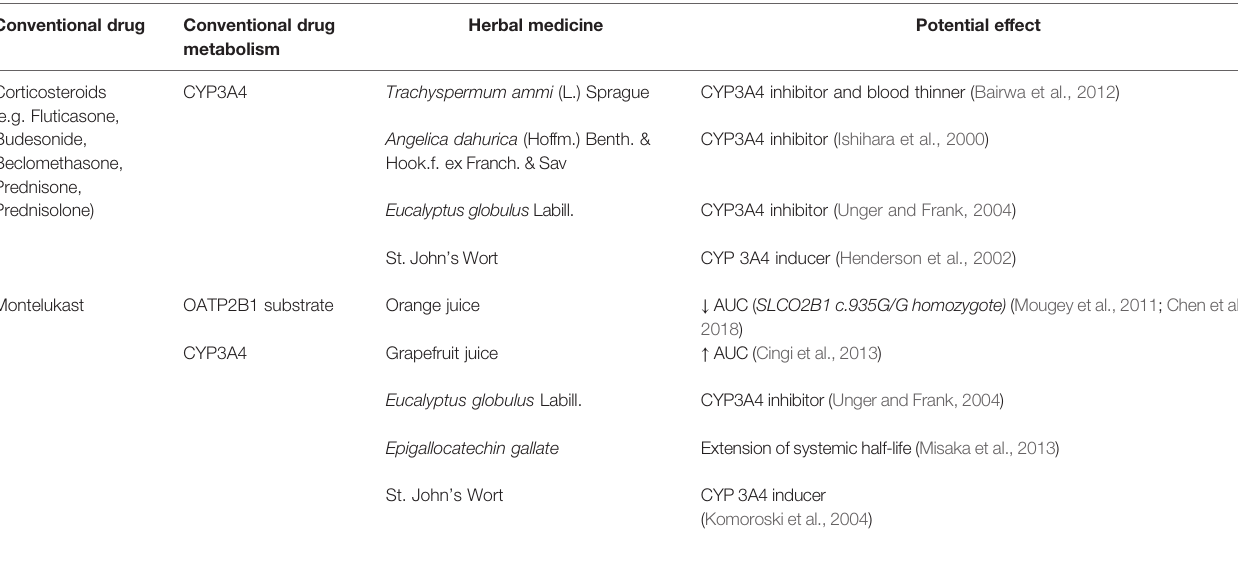
TABLE 4 | Potential HM interactions with conventional asthma control drugs taken by pregnant